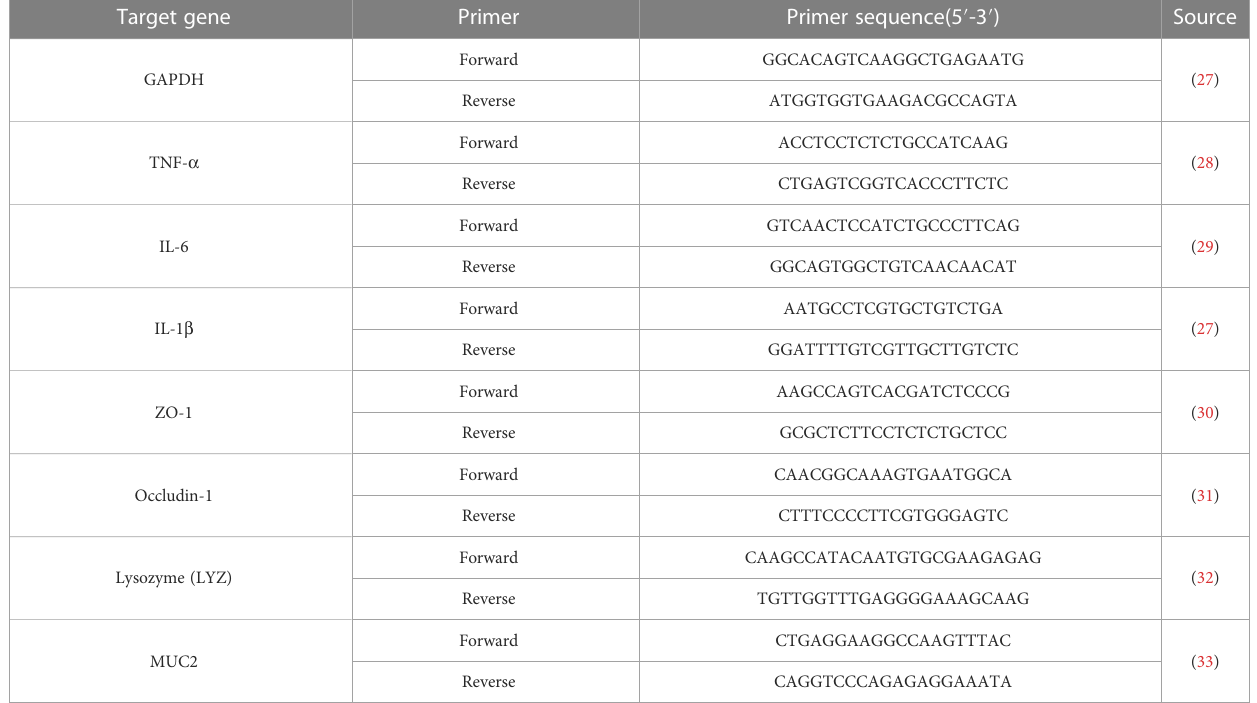
TABLE 2 The primers of the investigated genes for RT-qPCR